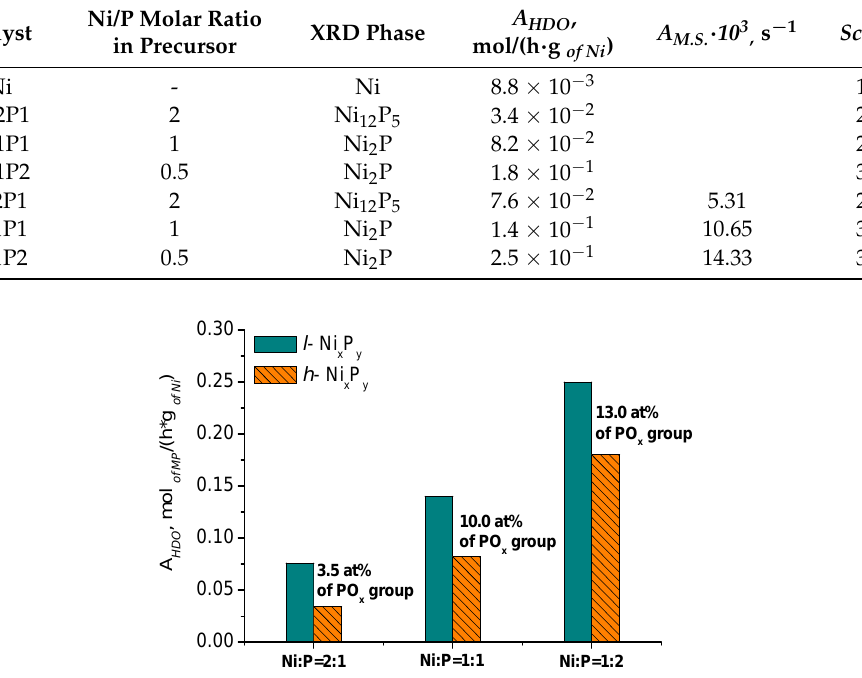
Figure 4. A HDO (mol/(h · g of Ni )) versus PO x (at %) for the catalysts with different Ni/P molar ratios: Ni2P1, Ni1P1, and Ni1P2. Catalytic activity, A HDO , of 2.5 wt % Ni x P y /SiO 2 and 7.0 wt % Ni x P y /SiO 2 catalysts prepared with different Ni:P molar ratios in methyl palmitate HDO at the temperature = 290 ◦ C and hydrogen pressure = 3.0 MPa. For the series of 7.0 wt % Ni x P y /SiO 2 catalysts ( h -Ni2P1, h -Ni1P1, and h -Ni1P2) it was pointed the amount of PO x (at %) determined by 31